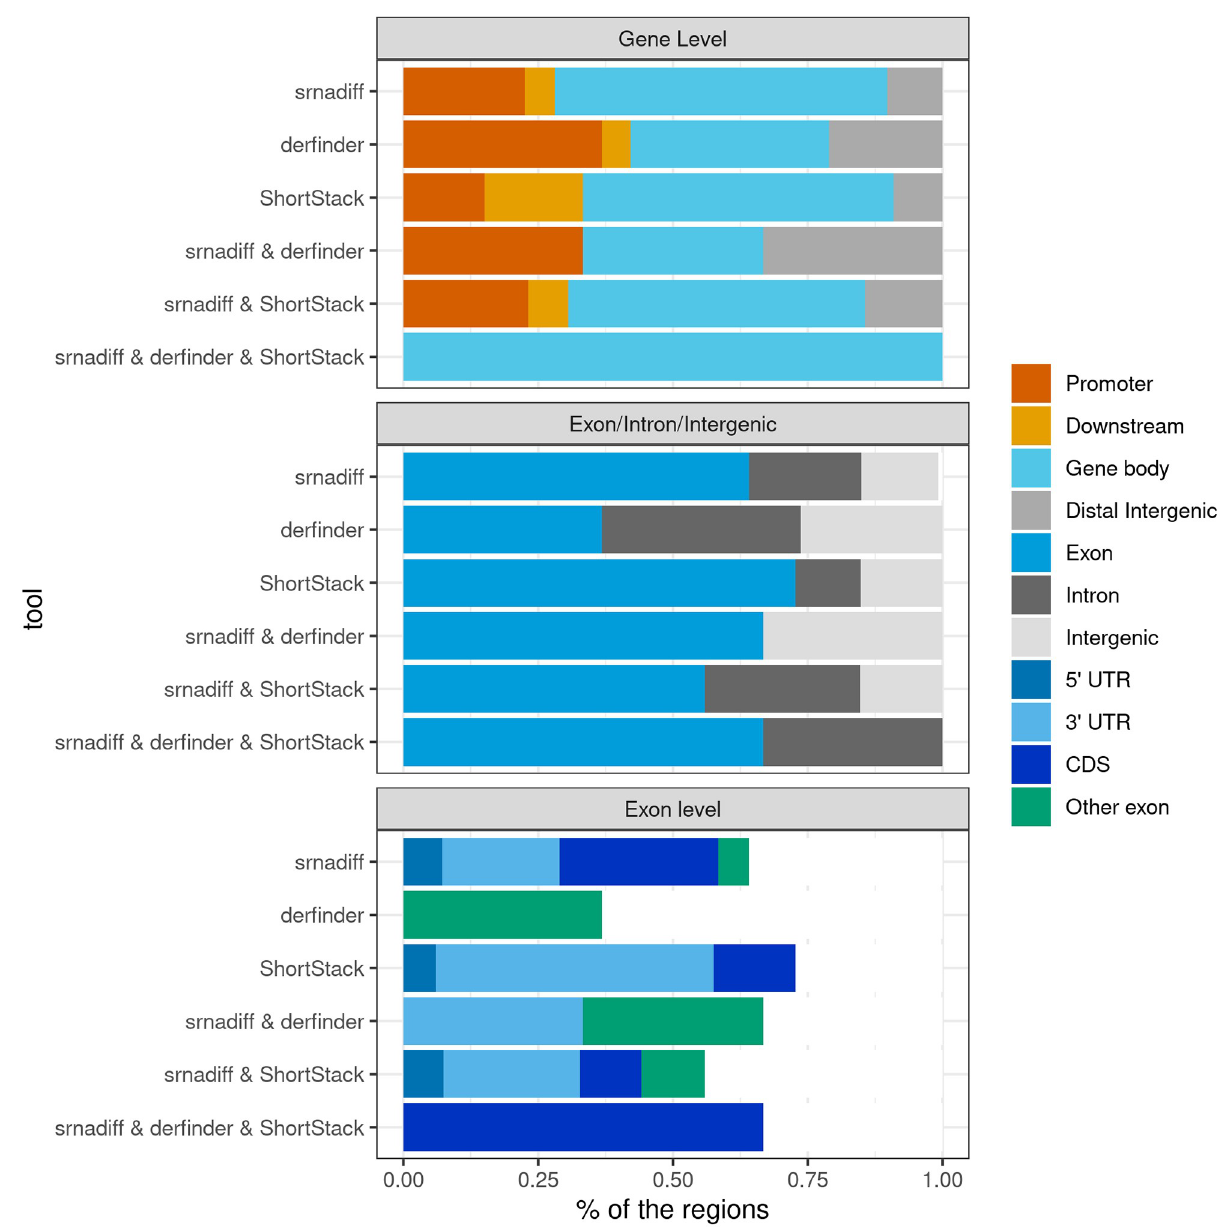
Fig 5. Genomic distribution of uncharacterized differentially expressed regions. Each bar plot shows the distribution of the differentially expressed regions outside of known miRNAs, piRNAs, tRFs, snoRNAs, found by one of the tools, or a combination thereof. In the top bar plots, the promoter is defined as the upstream regions of the genes, up to 2000 nucleotides. Likewise, downstream regions are 2000-nucleotide